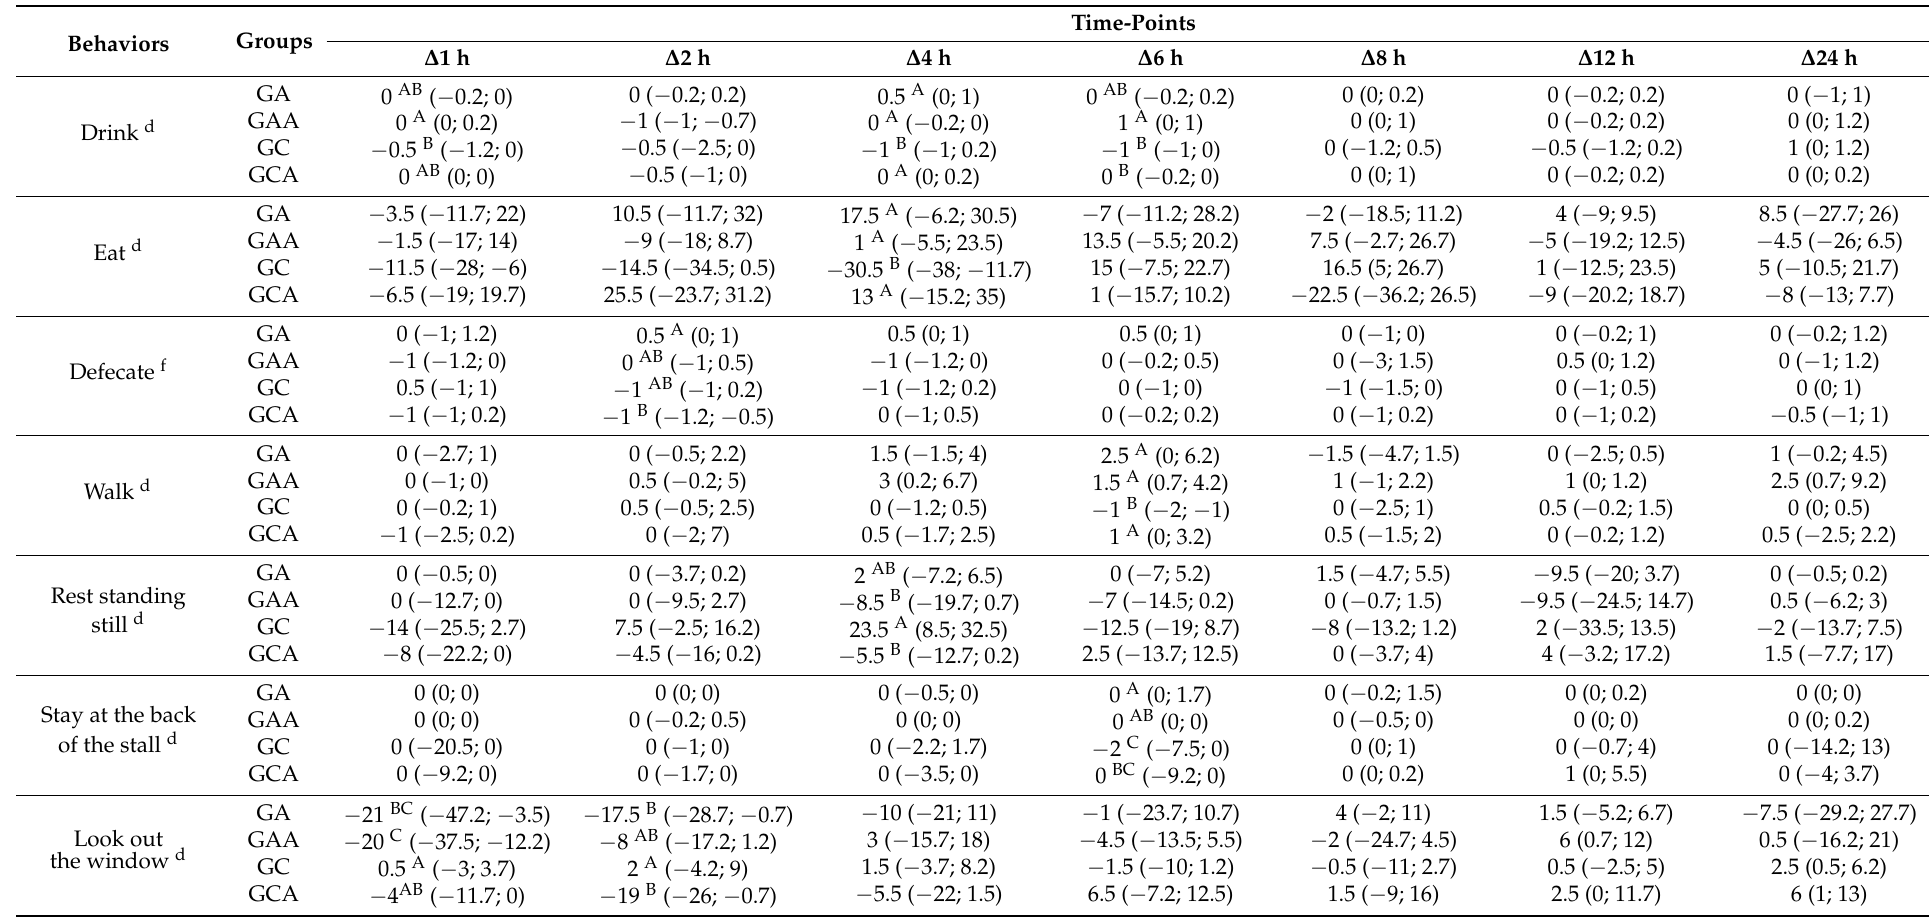
Table 2. Median and interquartile range (Q 1 ; Q 3 ) of the delta ( ∆ ) of the frequency or duration of the behaviors that showed differences between groups of horses submitted to anesthesia (GA), previous analgesia and anesthesia (GAA), anesthesia, orchiectomy, and postoperative analgesia (GC) and preoperative analgesia, anesthesia, and orchiectomy (GCA). The delta ( ∆ ) is the subtraction of the frequency and duration of the behaviors recorded after the anesthesia from those recorded in the mirrored hours before the anesthesia. Different uppercase letters and values in bold indicate a significant difference between groups at each time-point (A > B > C). The vertical dashed black line indicates when postoperative analgesia was performed for the GC; d indicates behaviors assessed as duration and f as